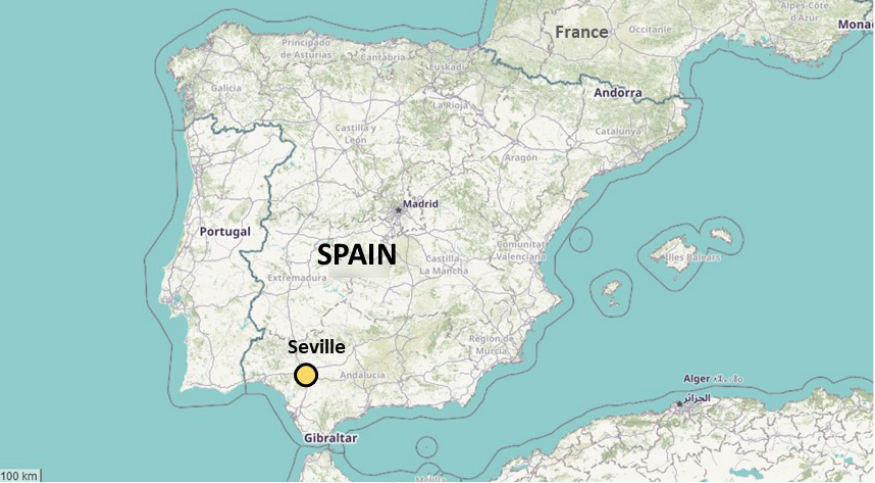
Figure 1. Seville location, in the southwest of Spain. Source: author elaboration laid over Open-StreetMap.